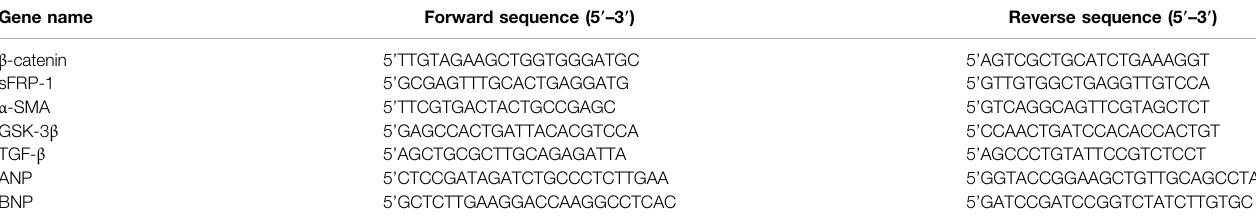
TABLE 1 | Information of primers for